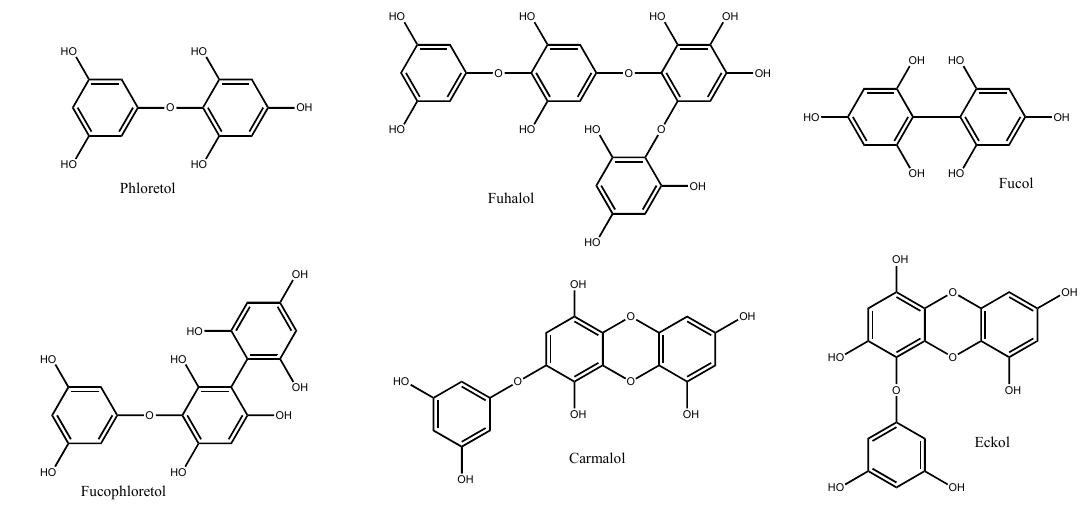
Figure 2. Different classes of phlorotannins [23].